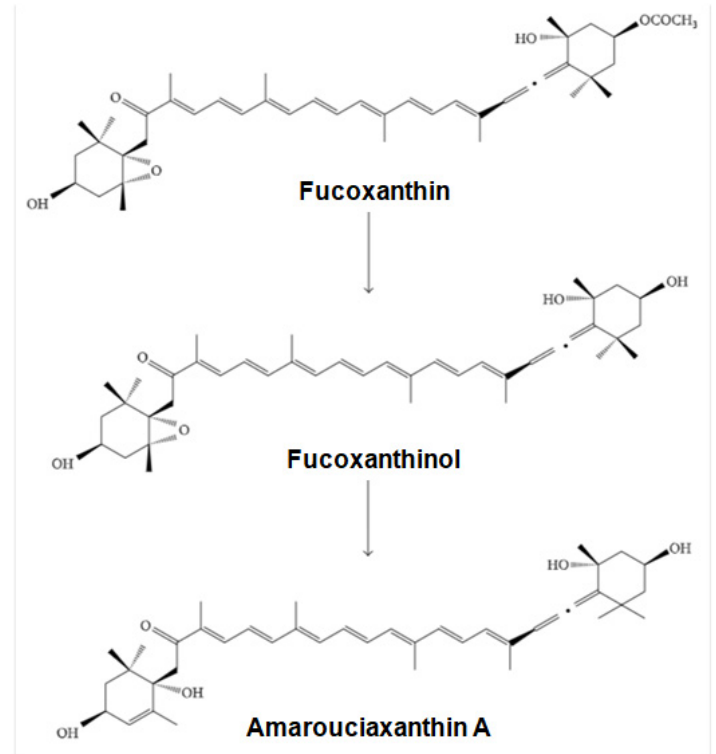
Figure 3. Fucoxanthin metabolism to fucoxanthinol and amarouciaxanthin A [100].